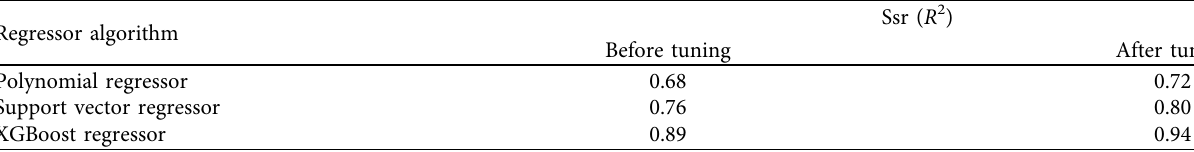
Table 4: Performance evaluation of three different regression models.